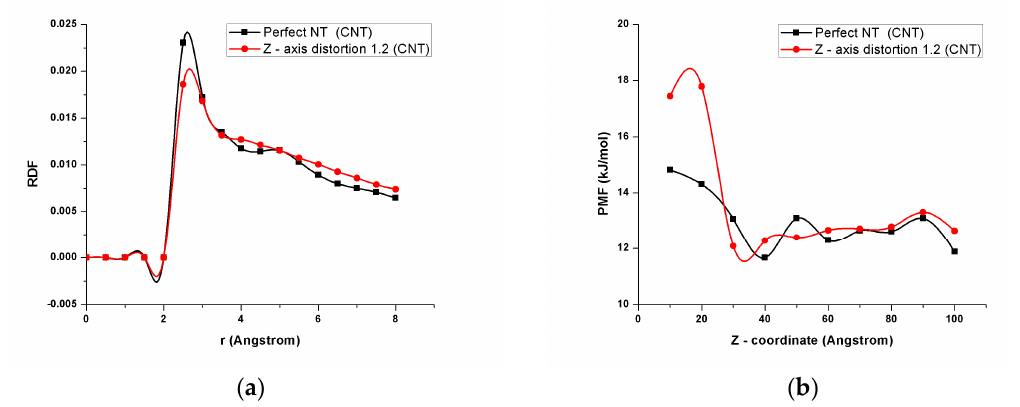
Figure 11. ( a ) Radial distribution function of water molecules within the perfect carbon nanotube and carbon nanotube with Z-distortion 1.2. ( b ) Potential of mean force within the perfect carbon nanotube and carbon nanotube with Z-distortion